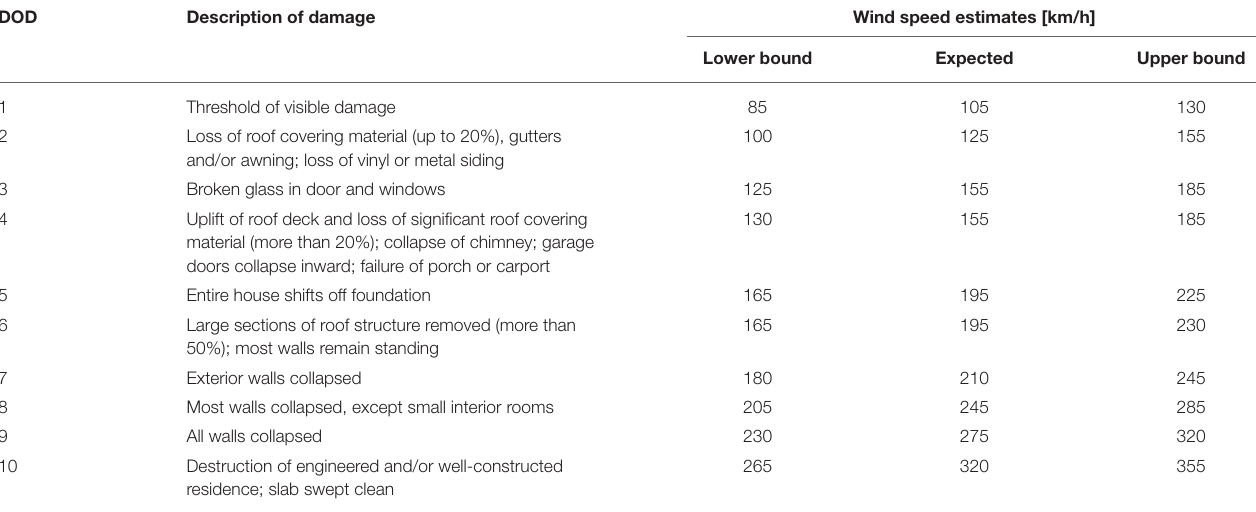
TABLE 1 | DOD descriptions and wind speed estimates for single-family residential structures, as adopted by Environment Canada (2013).